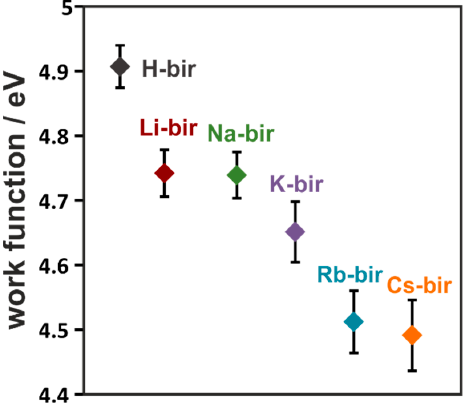
Figure 6. Influence of the introduced bulk alkali cations on the work function of the birnessite phase.